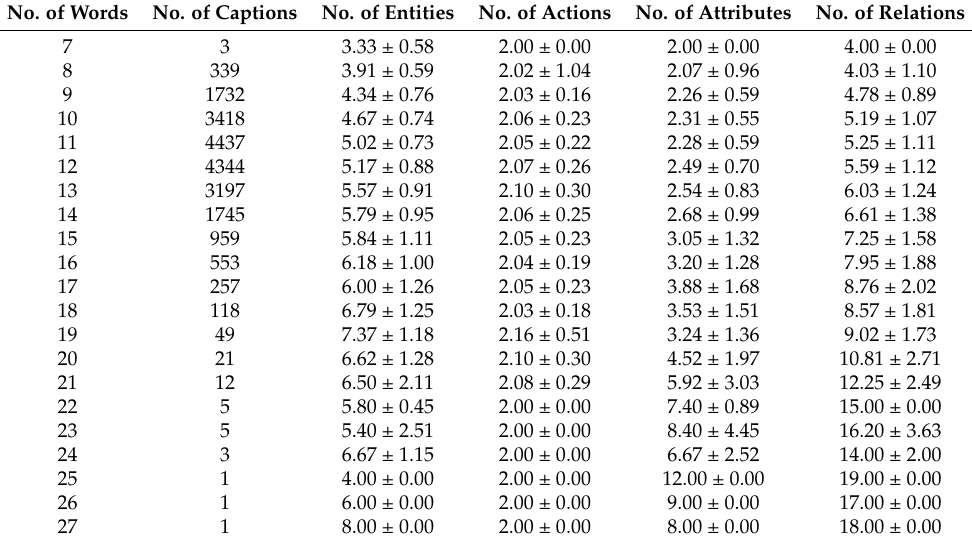
Table 3. A statistical analysis of the number of entities, action, attributes, and relations generated in the concept graph for captions of various